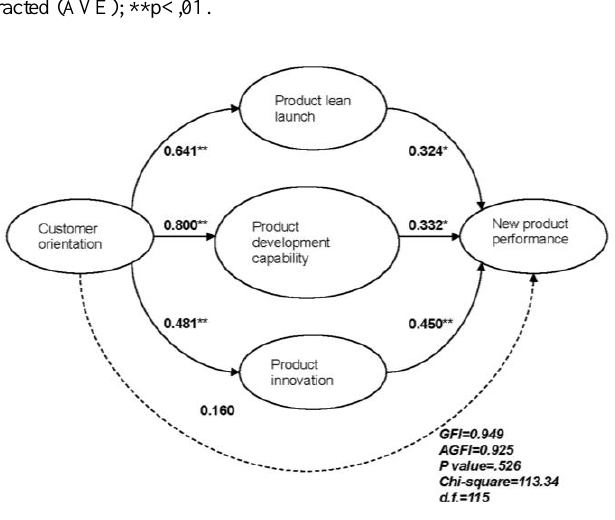
Figure 1: Analysis results of structural equation model